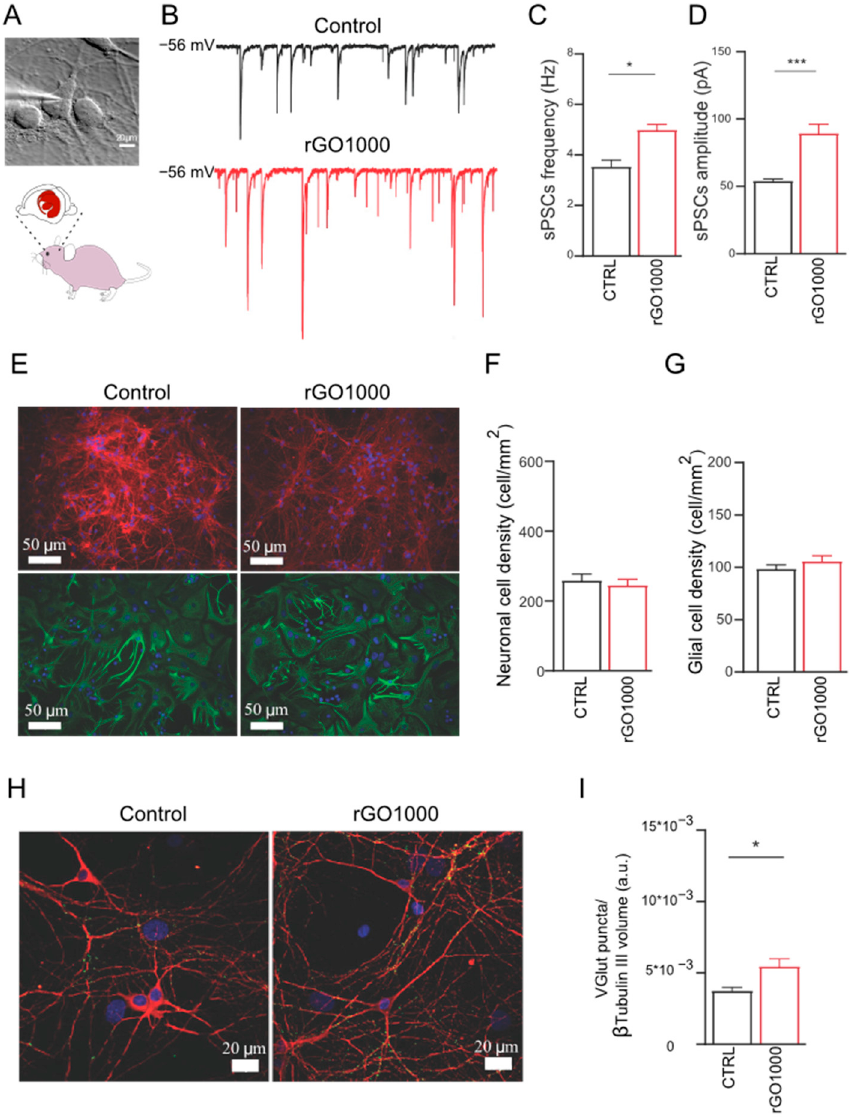
Figure 4. Chronic incubation of dissociated neuronal cultures with rGO1000 boosts synaptic activity. ( A ) Dissociated neuronal cultures were obtained from a rat brain and after exposure to rGO1000, were analyzed through the patch-clamp technique to monitor neuronal activity. ( B ) Exemplificative voltage-clamp traces recorded at − 56 mV of holding potential from cultures of control and those treated with rGO1000 (10 µ g/mL for 6–8 days in vitro). Bar plots show pooled data and summarize average sPSCs frequency ( C ) and amplitude ( D ). Note the significant increase in rGO1000 treated cultures for both sPSC frequency and amplitude. ( E ) Immunofluorescence images are represented to observe neurons and glial cells in the two different conditions (anti- β -tubulin III in red; anti-GFAP in green; in all, nuclei are shown with DAPI in blue). The plots summarize neuronal ( F ) and glial ( G ) densities in the different conditions. ( H ) Confocal reconstructions of control and rGO1000 treated neurons stained for the vesicular glutamate transporter 1 (VGLUT1 in green) and co-immunolabelled for cytoskeletal component β -tubulin III (red; nuclei are stained with DAPI in blue). ( I ) Bar plot shows the statistically significant increase of VGLUT1-positive puncta in rGO1000 treated cultures respect to the control. Statistical significance expressed as * p < 0.033 , *** p < 0.001.